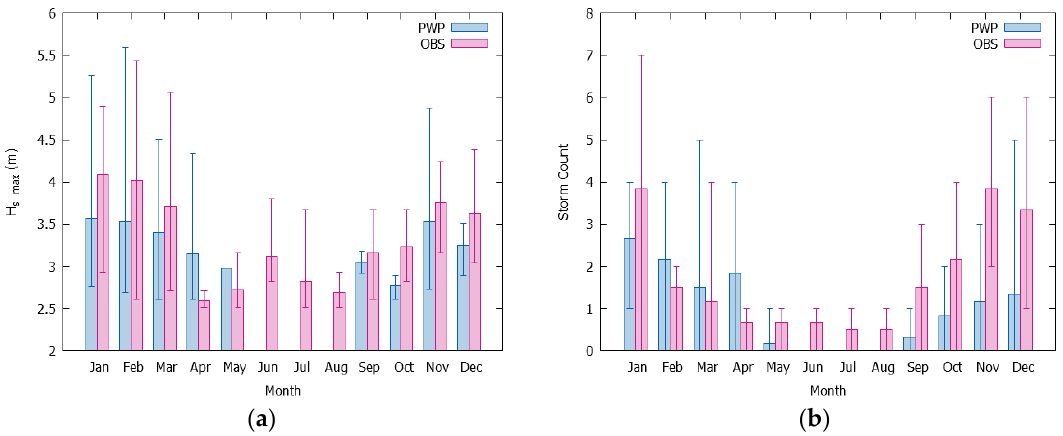
Figure 5. Comparison of observed and modelled “present” annual averaged monthly 𝐻 𝑠 max and storm count for Liverpool Bay. ( a ) 𝐻 𝑠 present wave projection (PWP) compared to the observed (OBS); ( b ) storm count PWP compared to the observed.